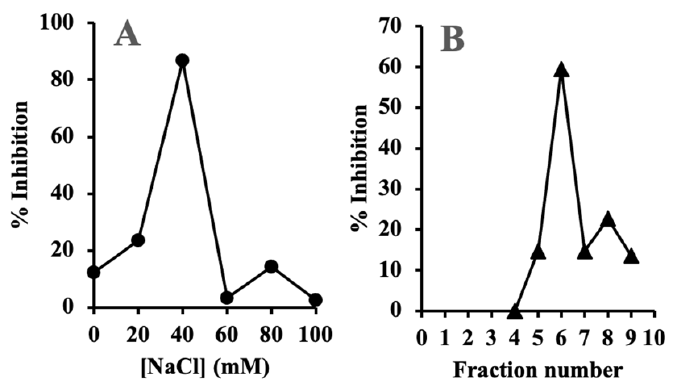
Figure 4. Chromatographic purification of aqueous extract from rhubarb stalk. ( A ) DEAE Sephadex A-25 anion exchange chromatography. ( B ) Sephadex G-25 gel filtration chromatography of the active fraction from A. Y4 strain was used for growth inhibition measurements.